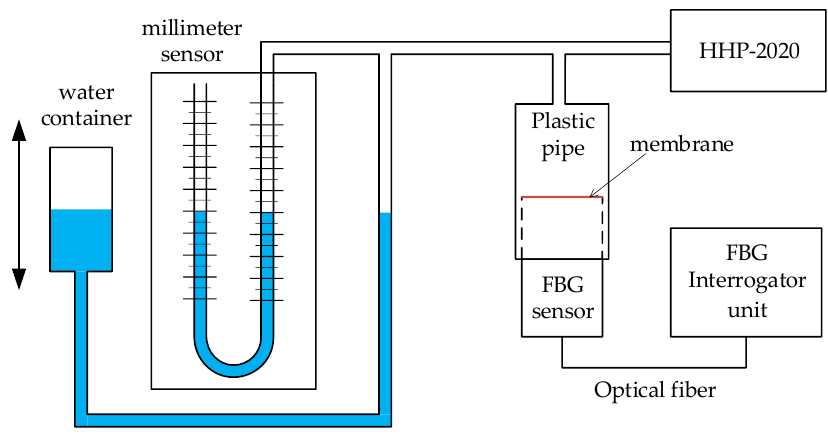
Figure 7. Diagram of experimental pressure measurement using a millimeter sensor, digital manome- ter HHP-2020, and FBG sensors.